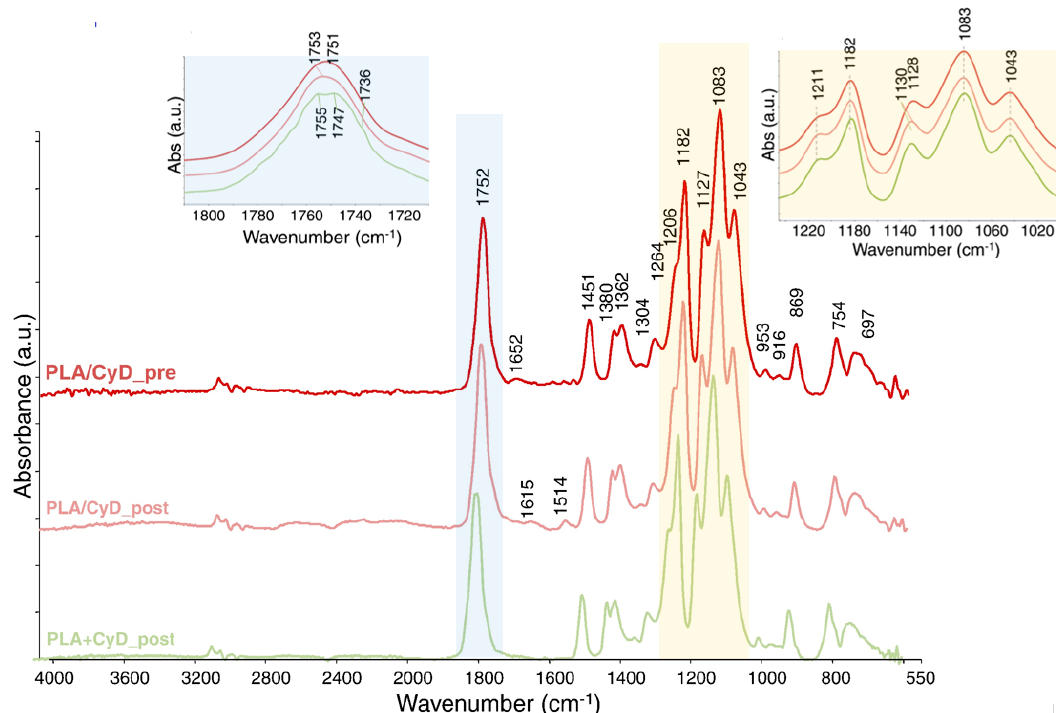
Figure 6. Comparison between all the filters containing